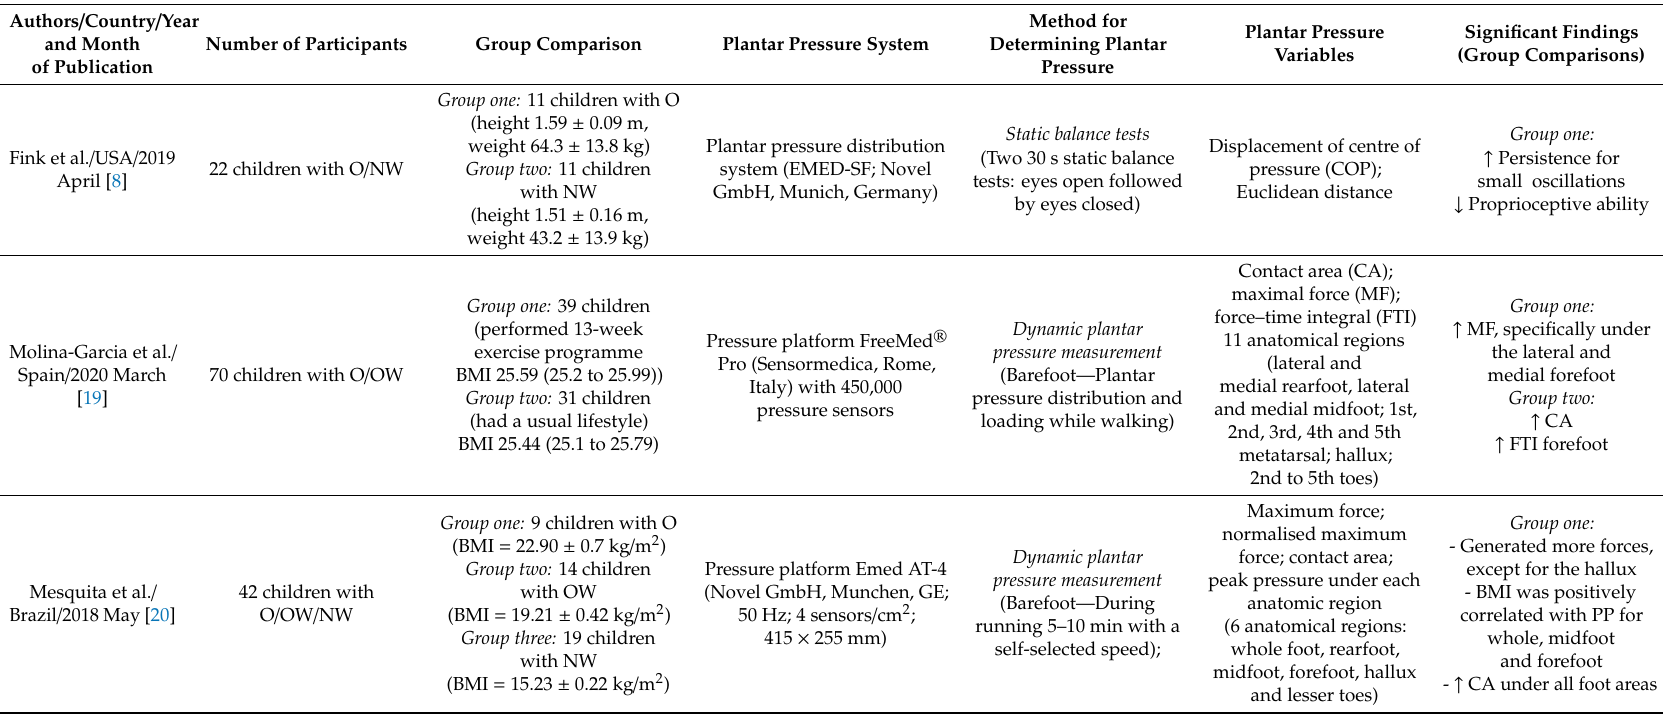
Table 1. Summary of included